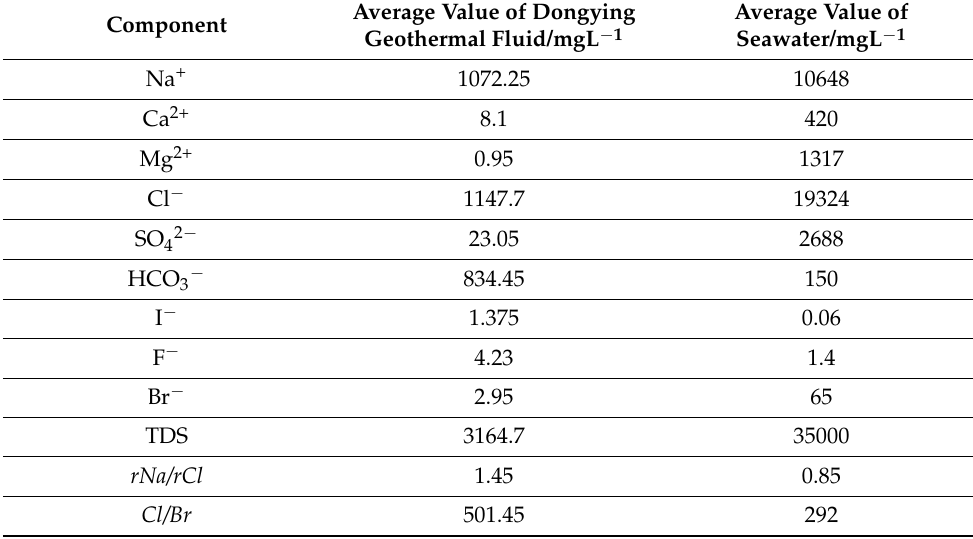
Table 6. Correlation table of chemical characteristics between Dongying geothermal fluid and seawater.